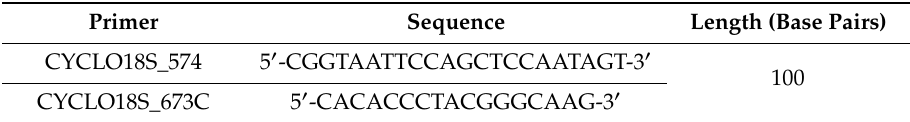
Table 1. Novel PCR primers designed to selectively amplify Cyclospora cayetanensis and exclude amplification of Eimeria spp .